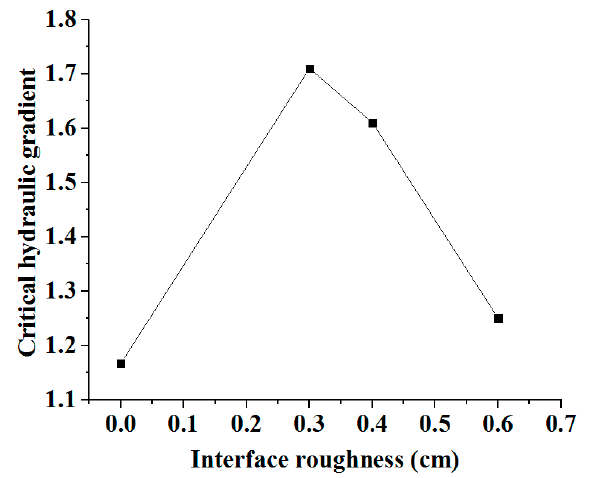
Figure 9. Critical hydraulic gradients for different roughnesses.